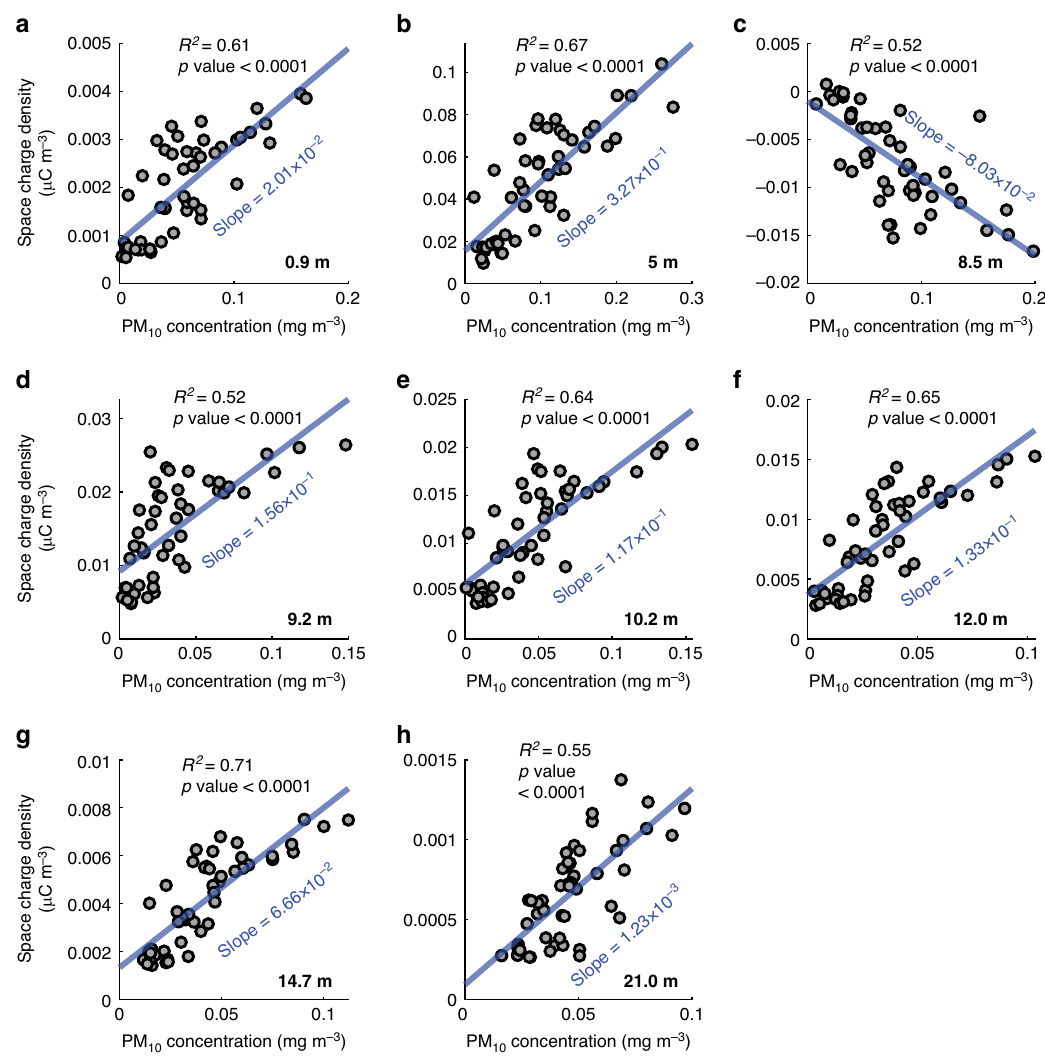
Fig. 7 Signi fi cant linear relationships between the PM 10 concentrations and space-charge densities for storm #1. a – h Linear relationships at the heights from 0.9 m to 21 m. The PM 10 concentration data for 30 m was not available during storm #1. Here, symbols denote the reconstructed space-charge density vs. the 2 9 s time-varying mean of the measured PM 10 concentration (extracted by the discrete wavelet transform), and lines denote linear regressions (coef fi cient of determination R 2 and p value are shown). For these data, the ambient temperature and relative humidity are in the range of 16.7 ± 1.2 ∘ C and 17.4 ±